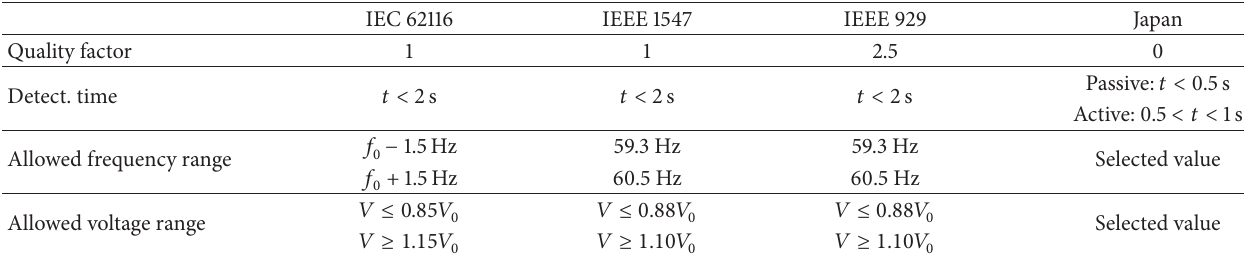
Table 1: Current standards for islanding detection.